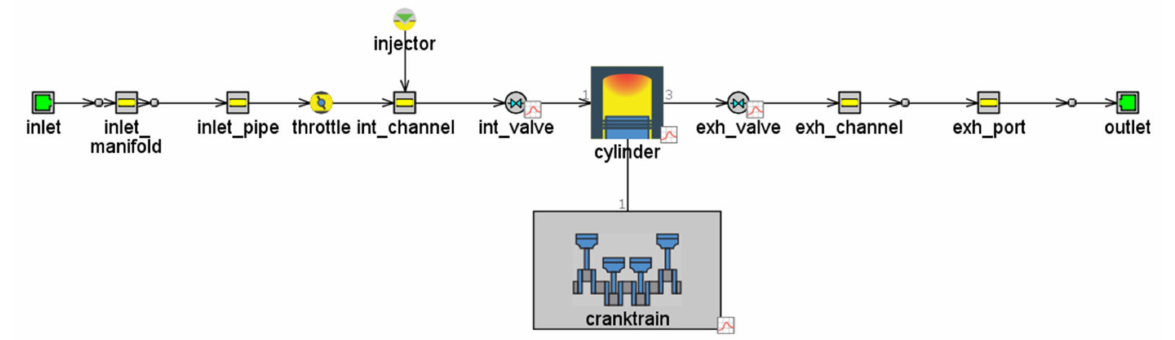
Figure 6. Thermodynamic model of a free-piston